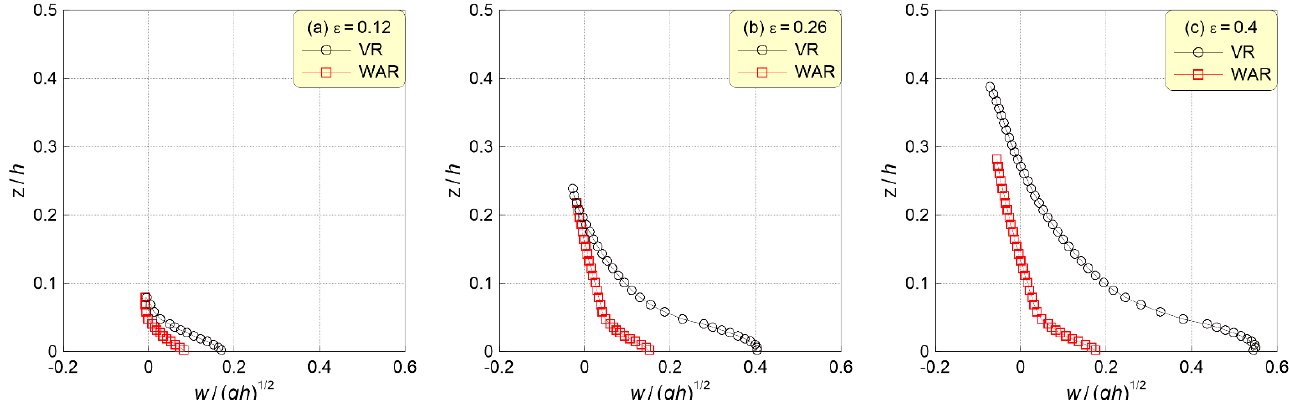
Figure 19. Vertical distribution of vertical velocity at the front of the vertical wall ( x / h = 0)— comparison between VR and WAR.